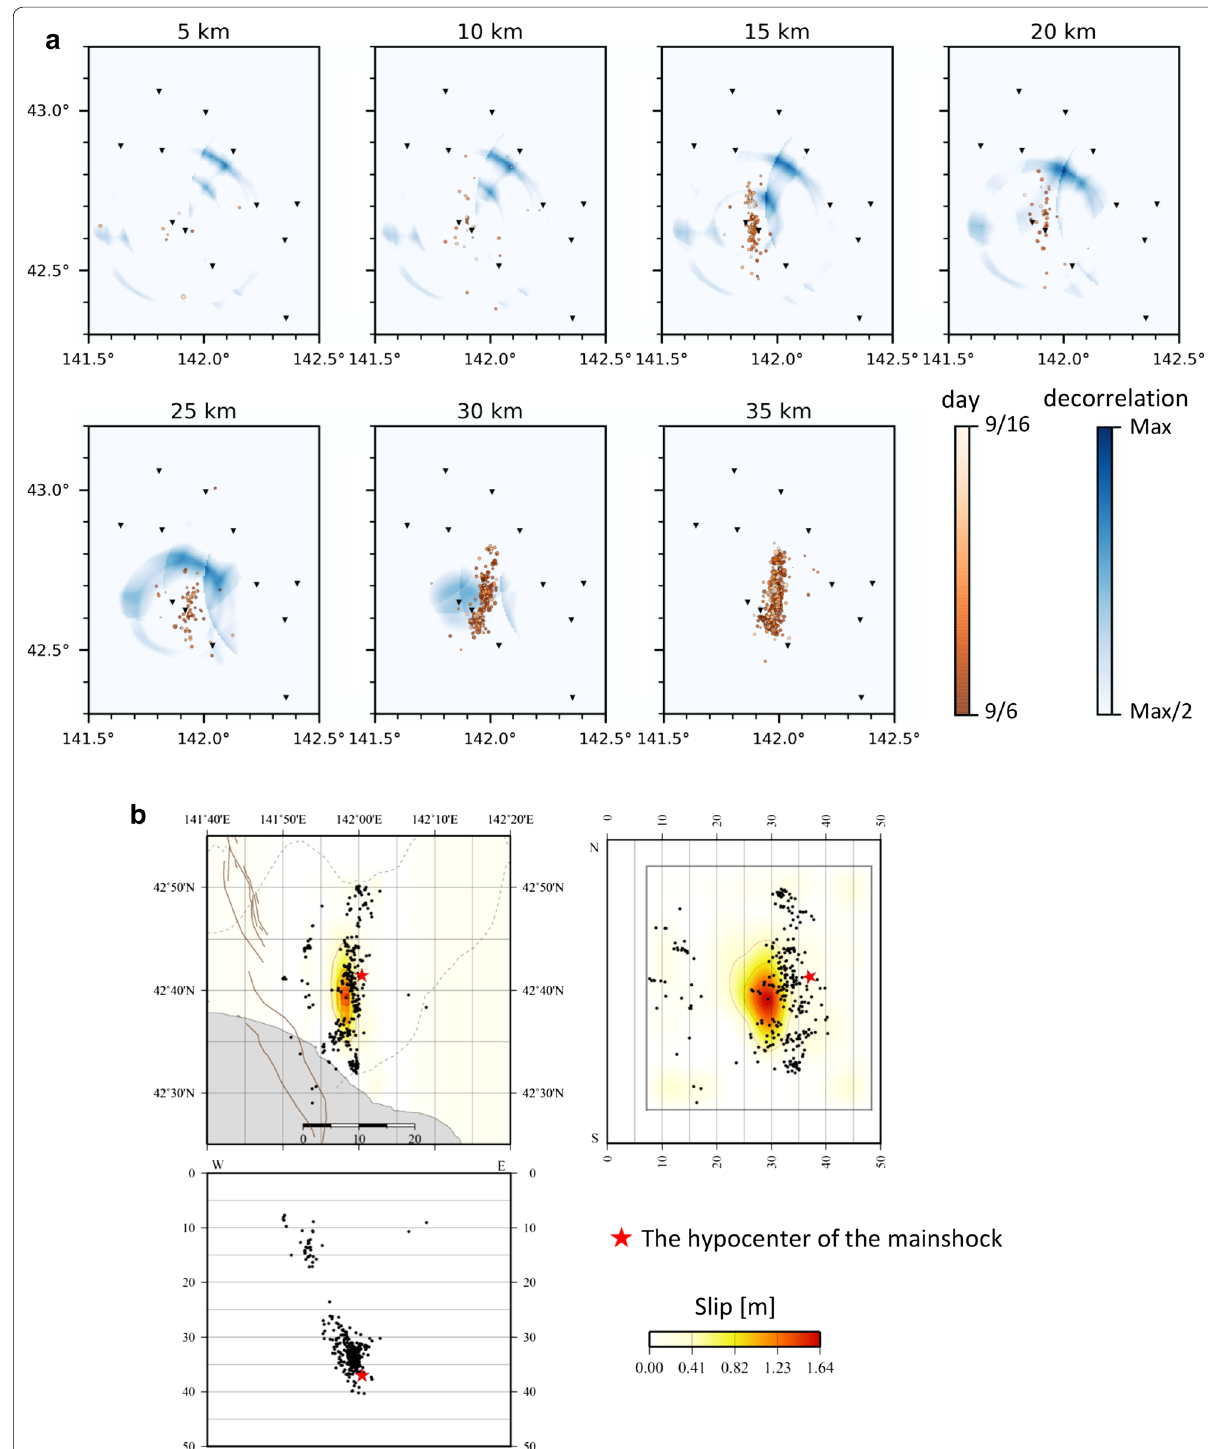
Fig. 6 a Analysis results of waveform decorrelation and distribution of seismicity at each depth. The blue color indicates decorrelation values within the blocks. Values of half of the maximum decorrelation value from this study, or more, are colored. Seismicity is plotted from September 6 to September 16, 2018. Each plot size indicates earthquake magnitude, and color indicates when the earthquake occurred. The triangles show locations of stations used in this study. b Figure reproduced from Japan Meteorological Agency (2018). The legends of the star and color scale in the original figure were translated into English from Japanese. The color contour shows the coseismic slip distribution estimated from near-field strong motion records. The black dots show the relocated hypocenters by using the double-difference